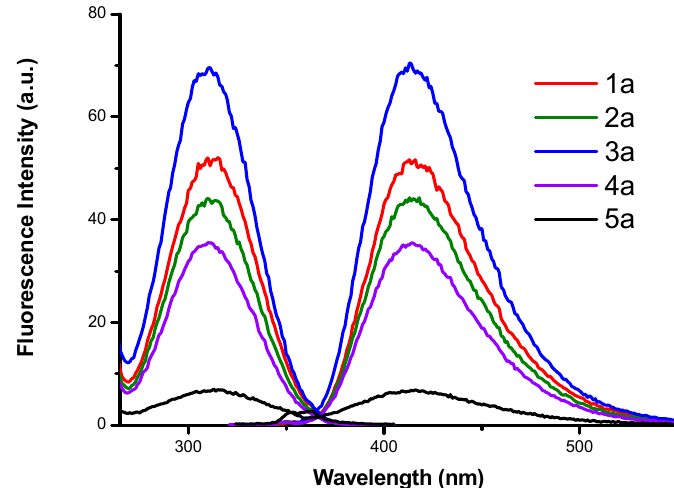
× 10 − 5 M] in water at